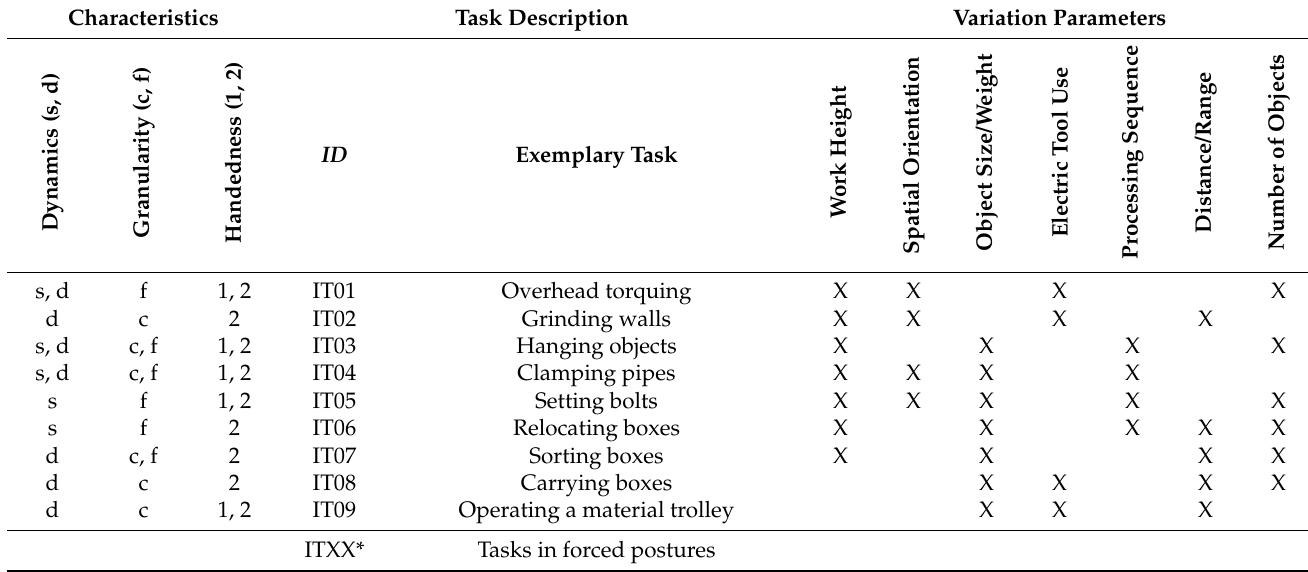
Table 1. Test pool for the evaluation of exemplary tasks for industrial exoskeletons. Characteristics Task